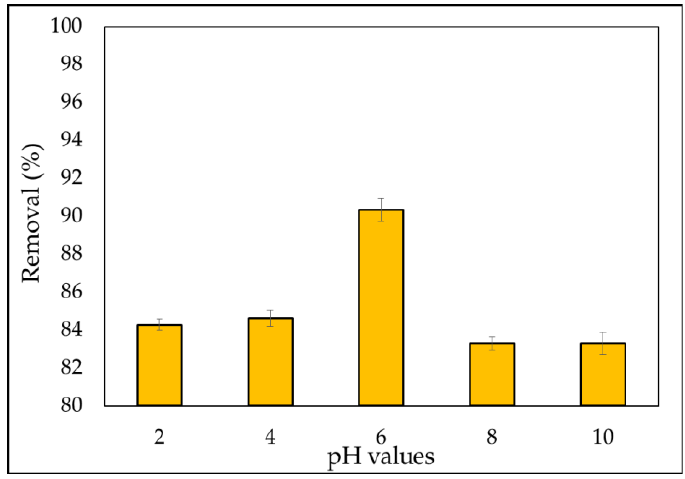
Figure 8. Effect of pH as a function of percentage removal of MBD (varying pH (2–10); dosage of A. platensis nanoparticles (0.1 g); MB dye initial concentration 5 mg L − 1 ; contact time 180 min; 180 rpm; and initial volume: 50